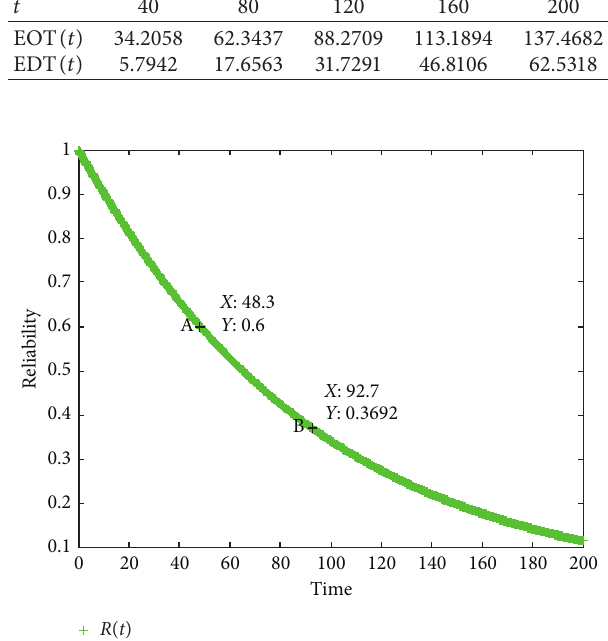
Figure 6: The curve of R ( t ) for the example without PM.